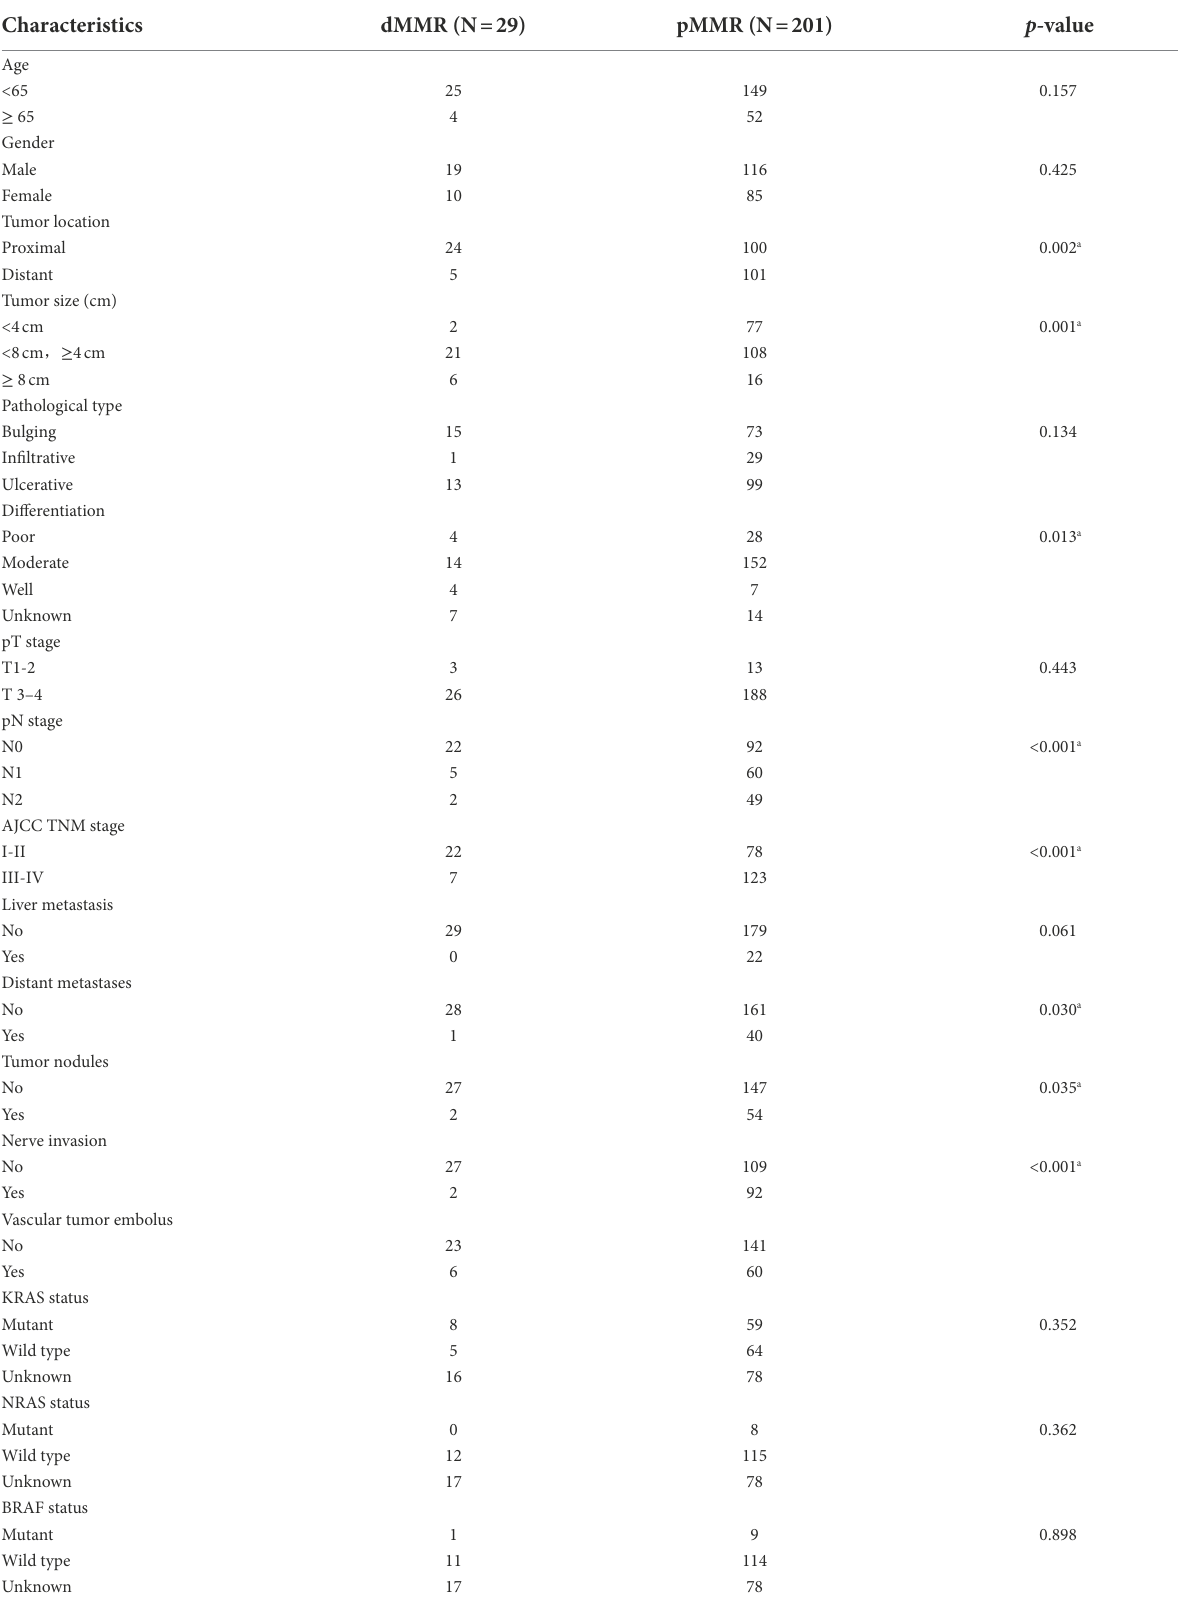
TABLE 2 Clinicopathologic features of the CRC patients with dMMR and pMMR status. Characteristics dMMR (N =